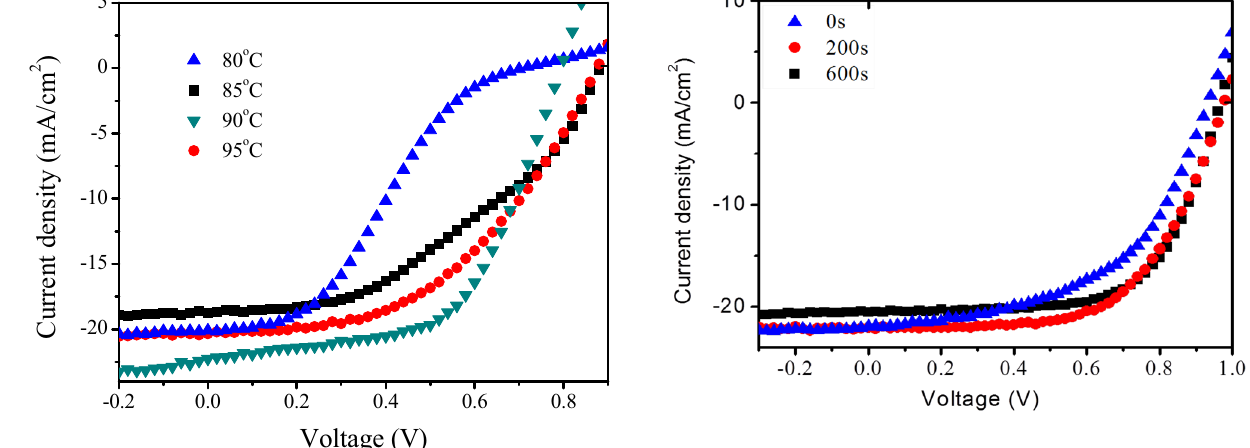
Fig. 10 J – V curves of devices obtained with different aging time Table 2 Photovoltaic properties of devices obtained from pre-anneal- ing aging of 0 s, 200 s and 600 s, respectively, before annealing at 90 °C for 5